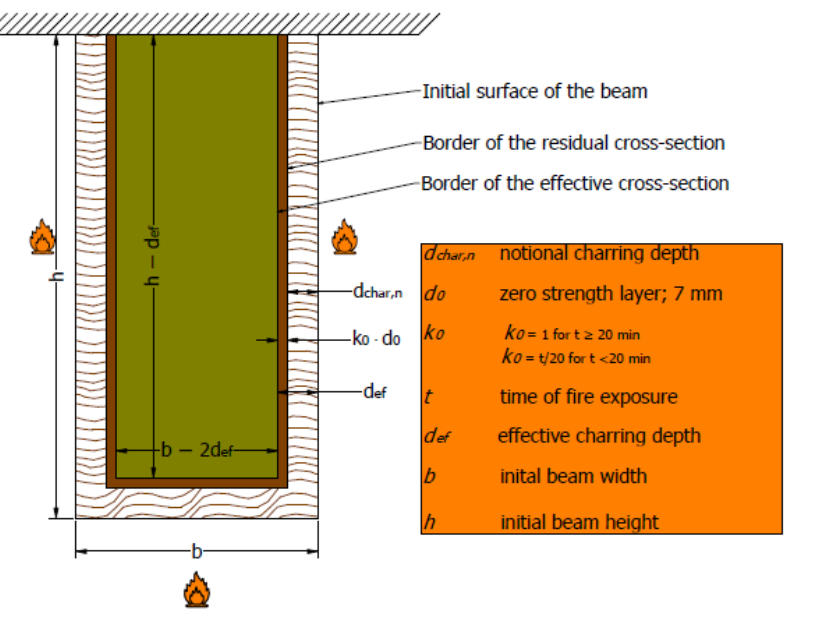
Figure 3. Definition of ideal residual cross- section (EN 1995 -1-2, 2004 [25]).